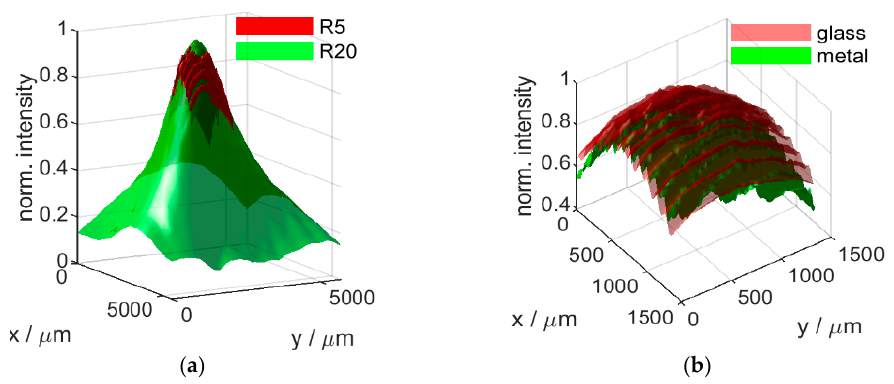
Figure 5. Normalized signal intensity defined as interference pattern amplitude at sample surface level for each sensor pixel for different measurements: R5 (low field-of-view) vs. R20 (high field-of-view) optics and glass surface ( a ); and glass vs. metal surface using R5 optics ( b ). Each signal intensity dataset (surface) shown is obtained by averaging 11 measurements on the same sample area, under identical conditions/settings, and is normalized using the maxima of the respective dataset. The measurements were taken using the highest instrument Z resolution.